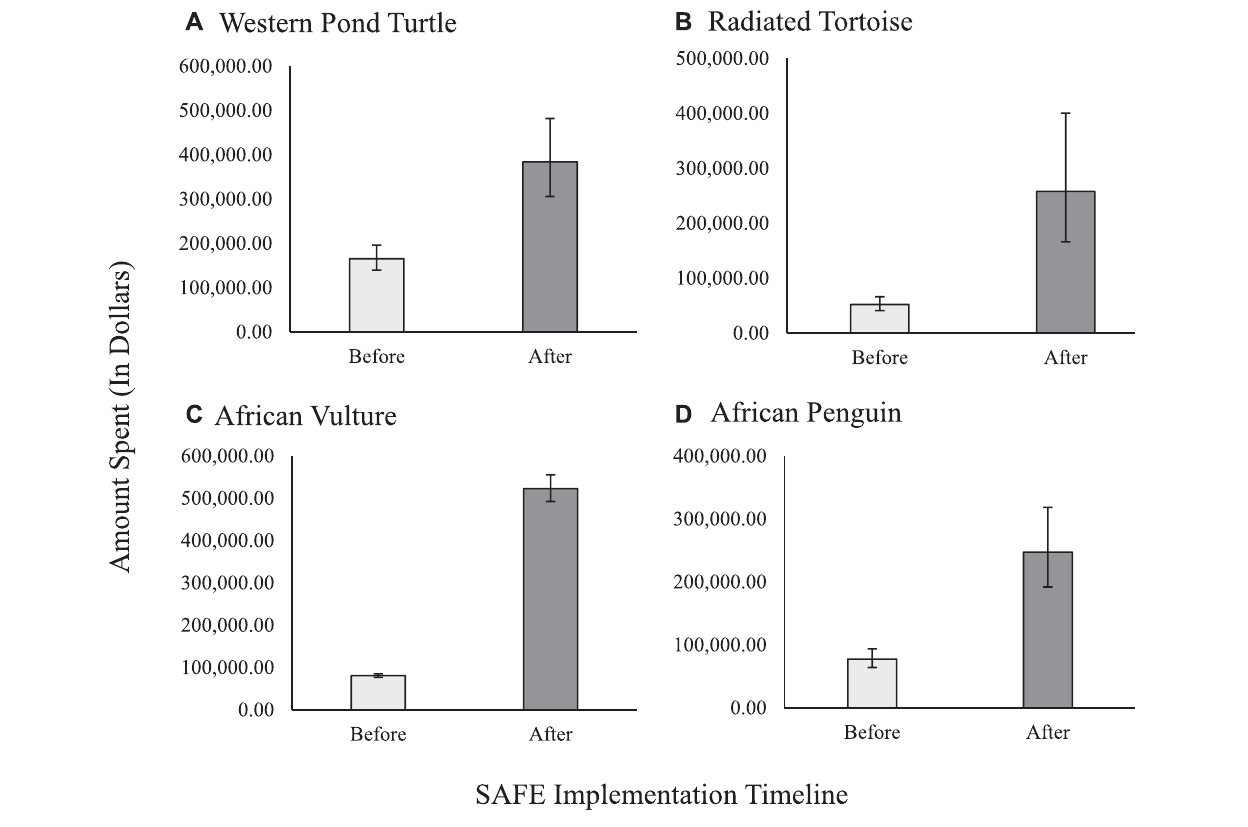
FIGURE 1 | Evaluation of the effect of SAFE project implementation on amount of funding contributed to in situ conservation projects for individual species programs. Programs include (A) Western Pond Turtle, (B) Radiated Tortoise, (C) African Vulture, and (D) African Penguin. Data is expressed as model generated means ± SEM. For (A) and (C) SAFE programs were implemented in 2015 (Before: 2011 – 2014, n (cid:1) 4 years ; After: 2015 – 2019, n (cid:1) 5 years ), while for (B) and (D) SAFE was implemented in 2017 (Before: 2011 – 2016 n (cid:1) 6 years ; After: 2017 – 2019 n (cid:1) 3 years ). Variation in SEM is indicative of variable effect of SAFE programs and variation between different